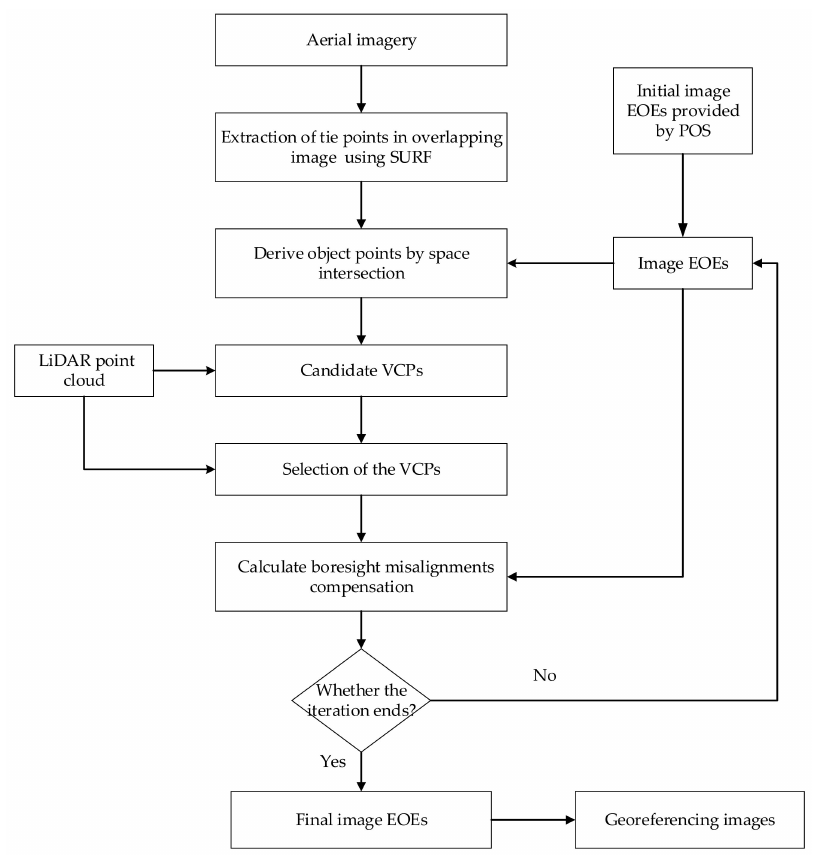
Figure 4. Flowchart of the proposed